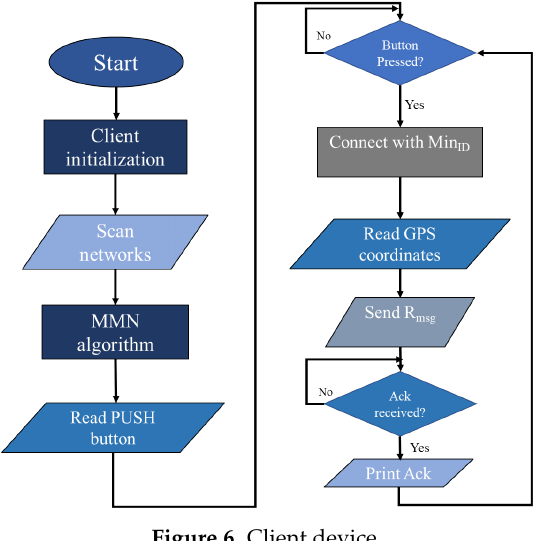
Figure 6. Client